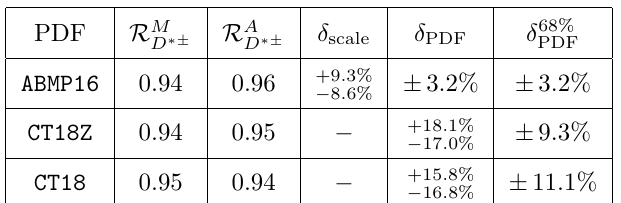
Table 3 . Our predictons for the ratio of integrated fiducial NLO + SMC cross sections R σ ( W + + D ∗− ) /σ ( W − + D ∗ + ) according to the CMS analysis at the Monash (second column) or the ATLAS A14 (third column) central tune. Also reported, for the simulations with the Monash tune, are the uncertainties, computed assuming uncorrelation between numerator and denominator, stemming from scale variation and from PDF variation within each considered PDF set. The last column reports symmetrized PDF uncertainties at 68%